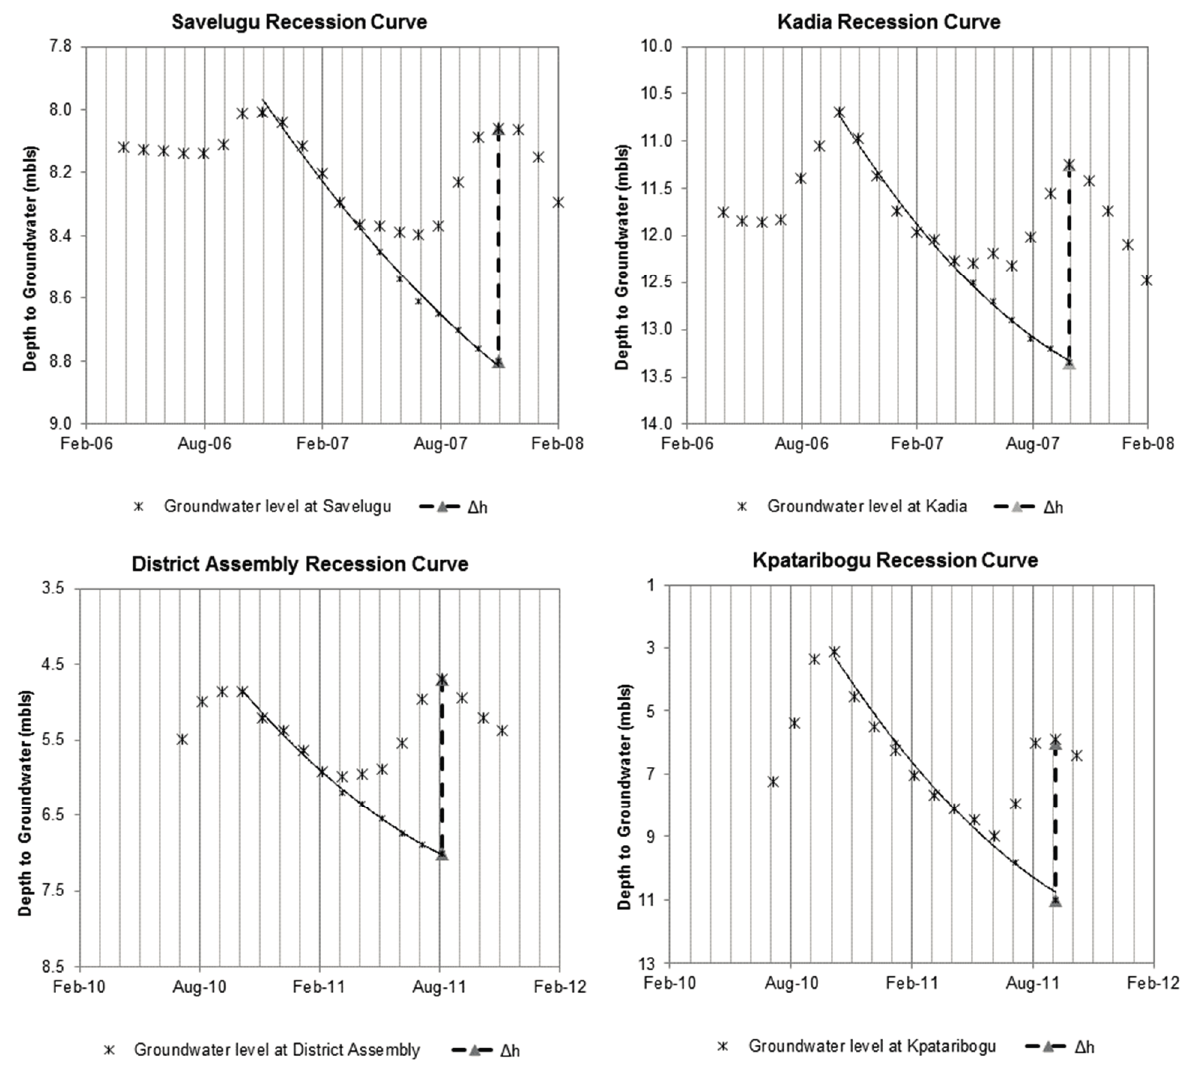
Figure 5. Extrapolated antecedent recession curves to determine Δ h for recharge calculations at the study